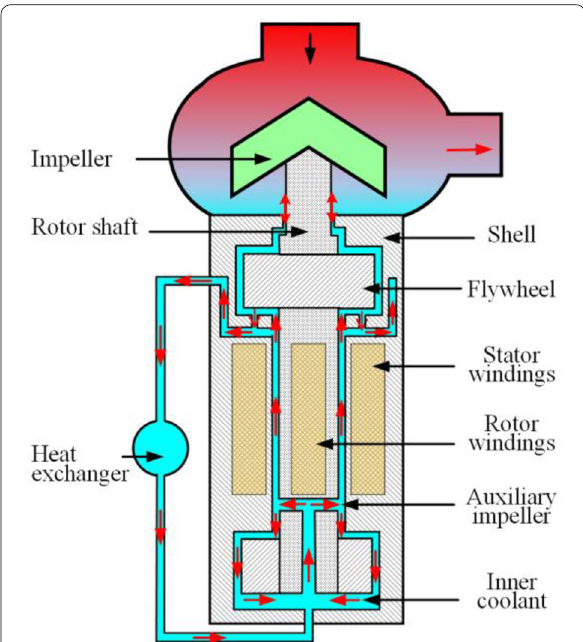
Figure 1 Inner circulation of the canned motor pump